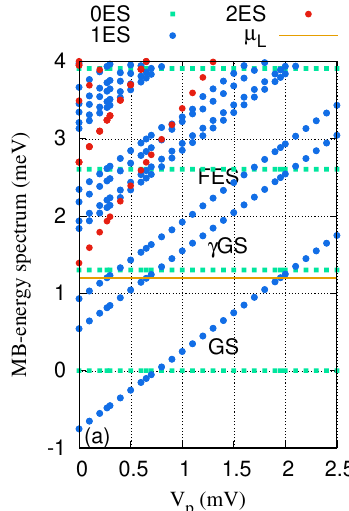
Figure 2. Many-body energy of the QD system versus the gate voltage (V p ), where 0ES (green squares) indicate zero-electron states, 1ES (blue circles) display one-electron states, and 2ES (red circles) refer to two-electron states. The golden line is the chemical potential of the leads where µ L = µ R = µ = 1.2 meV. GS indicates the one-electron ground-state, γ GS is the one-photon replica of the one-electron ground-state, and FES is the one-electron first-excited state. The photon energy ¯ h ω γ = 1.31 meV, the electron–photon coupling strength is g γ = 0.05 meV, and and the photon field is linearly polarized in the x -direction. The magnetic field is B = 0.1 T, and ¯ h Ω 0 = 2.0